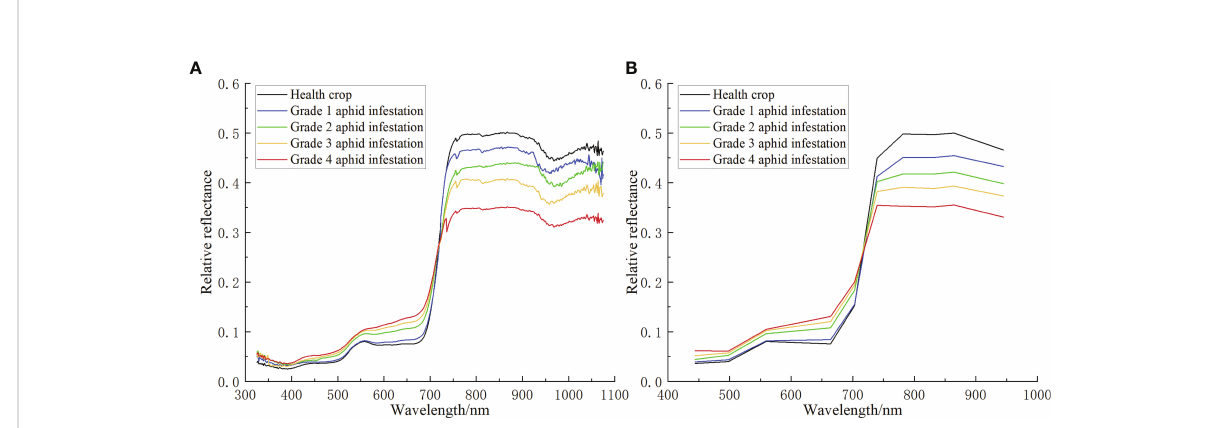
FIGURE 3 (A) The original ASD hyperspectral curve of aphid infestation at different grades in the cotton canopy. (B) The simulated ASD hyperspectral resampling curve of aphid infestation at different grades in the cotton